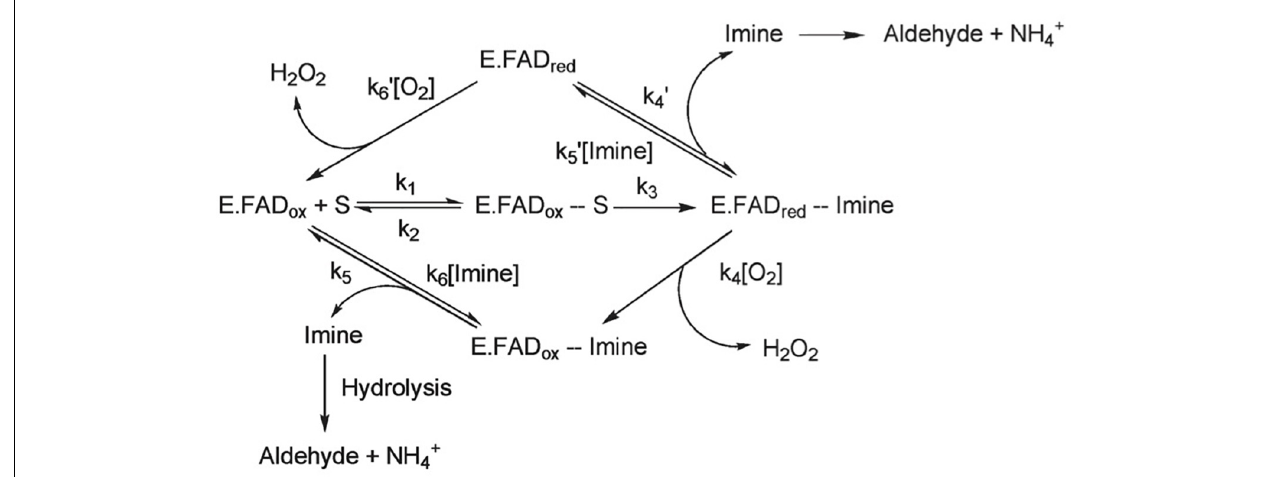
FIGURE 1 | MAO-B can follow one of two general catalytic reactions, however, for most substrates, the pathway depicted on the bottom of the figure is followed. In this pathway, oxygen reacts with the enzyme-product complex. It is believed that the substrate binds to the active site on MAO-B via a deprotonated amine moiety, where it is oxidized to a protonated imine and the covalent FAD cofactor is reduced to its hydroquinone form. FAD cofactor then reacts with O 2 to generate flavin and hydrogen peroxide, and an aldehyde is formed when the protonated imine is released from the enzyme and undergoes hydrolysis. Adapted with permission from Edmondson et al. (2009). Copyright © (2009) American Chemical